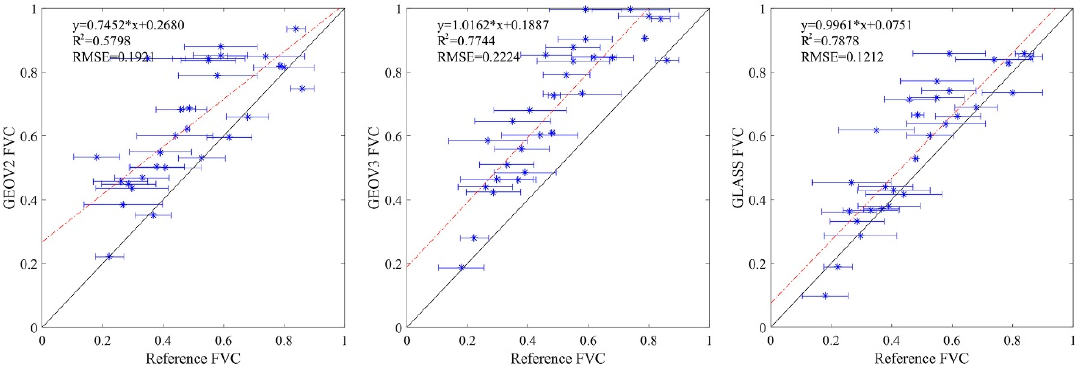
Figure 6. Scatterplots between different FVC products and high-spatial resolution reference FVC data.